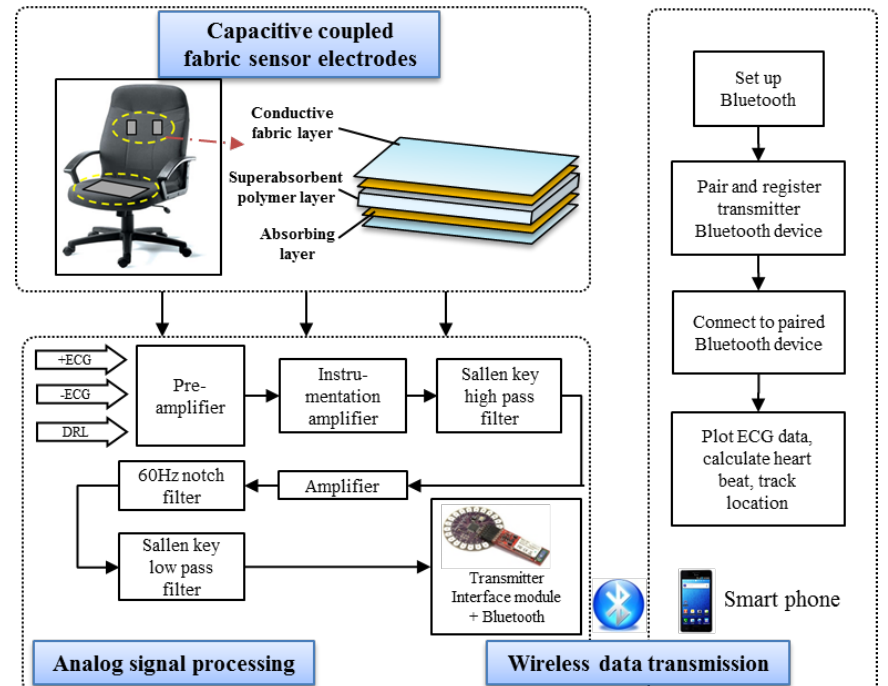
Figure 4. Flowchart of the data acquisition